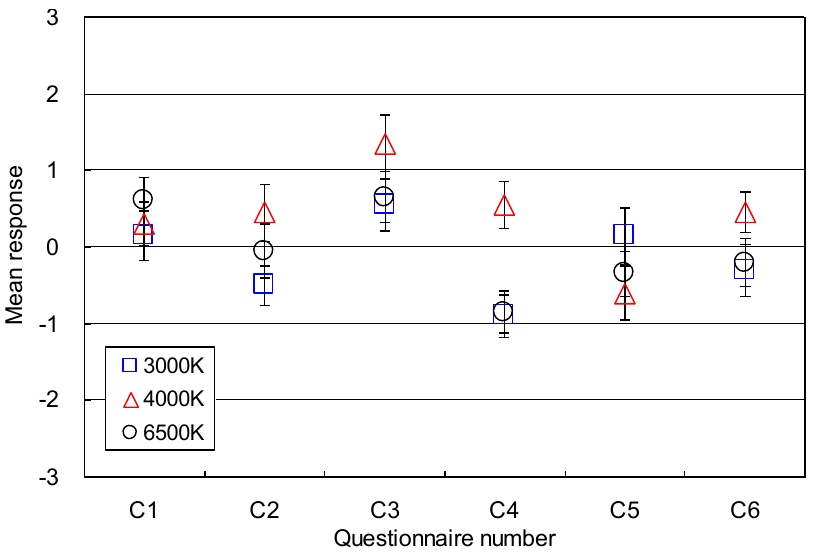
Figure 13. Visual comfort and annoyance (750 lx, Computer